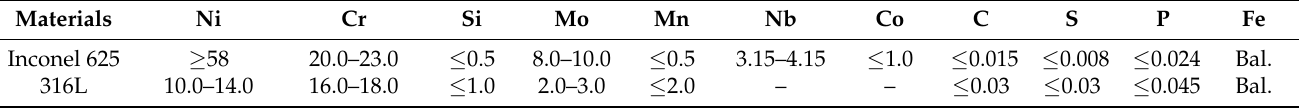
Figure 2. Schematic of the deposition process. Table 2. Deposition parameters used in experiments. Table 1. Chemical composition of Inconel 625 powder and 316L stainless steel.